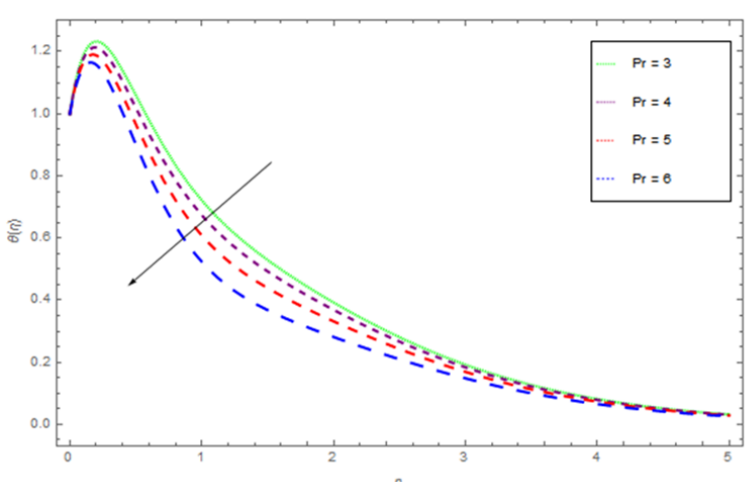
Figure 8. The e ff ect of N t on θ ( η ) when N b = 0.4, Pr = 4, γ = 1.2. Figure 8. The effect of t N on ( )   when 0 . 4 , P r 4 ,   .